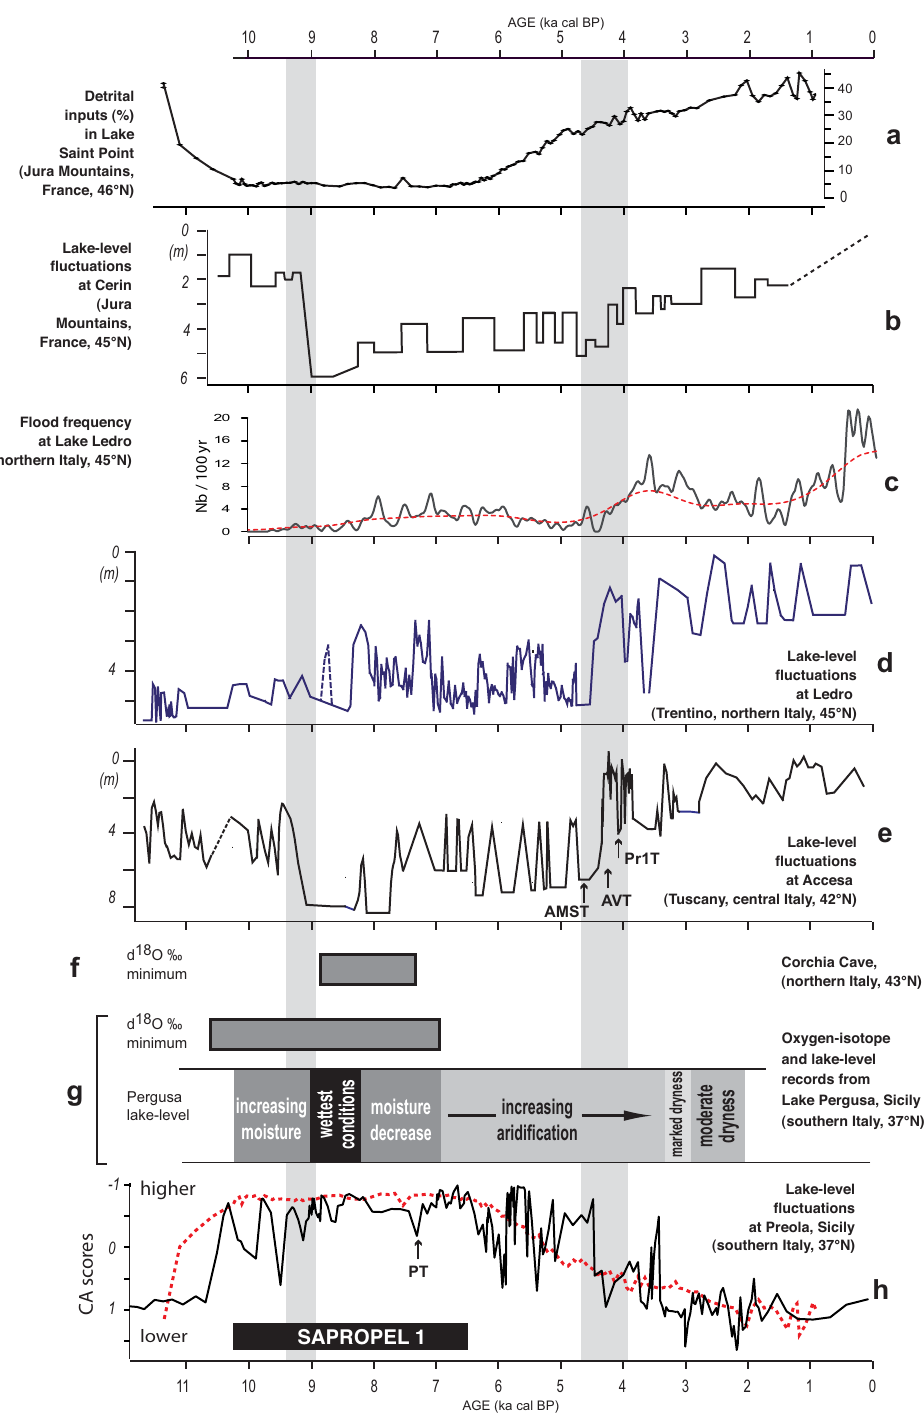
Fig. 3. Comparison between palaeohydrological records along a north–south transect from west-central Europe to the south-central Mediter- ranean, i.e. (a) Lake Saint-Point (Magny et al., 2013), (b) Lake Cerin (Magny et al., 2011a), (c and d) ) Lake Ledro (Vanni`ere et al., 2013; Magny et al., 2012b), (e) Lake Accesa (Magny et al., 2007), (f) Corchia Cave (Zanchetta et al., 2007b), (g) Lake Pergusa (Sadori and Narcisi, 2001; Zanchetta et al., 2007a; Sadori et al., 2008), and 8: Lake Preola (Magny et al., 2011b). The red curve in (h) is the Saint-Point palaeohy- drological record after inversion (see panel a) . The two vertical grey bands point out two major phases of palaeohydrological changes around 9000 and 4500calBP. Labels AMST, AVT and Pr1T in panel (e) correspond to the Agnano Mt Spina, Avellino and Pr1 tephras respectively, and PT in panel (h) to the Pantelleria